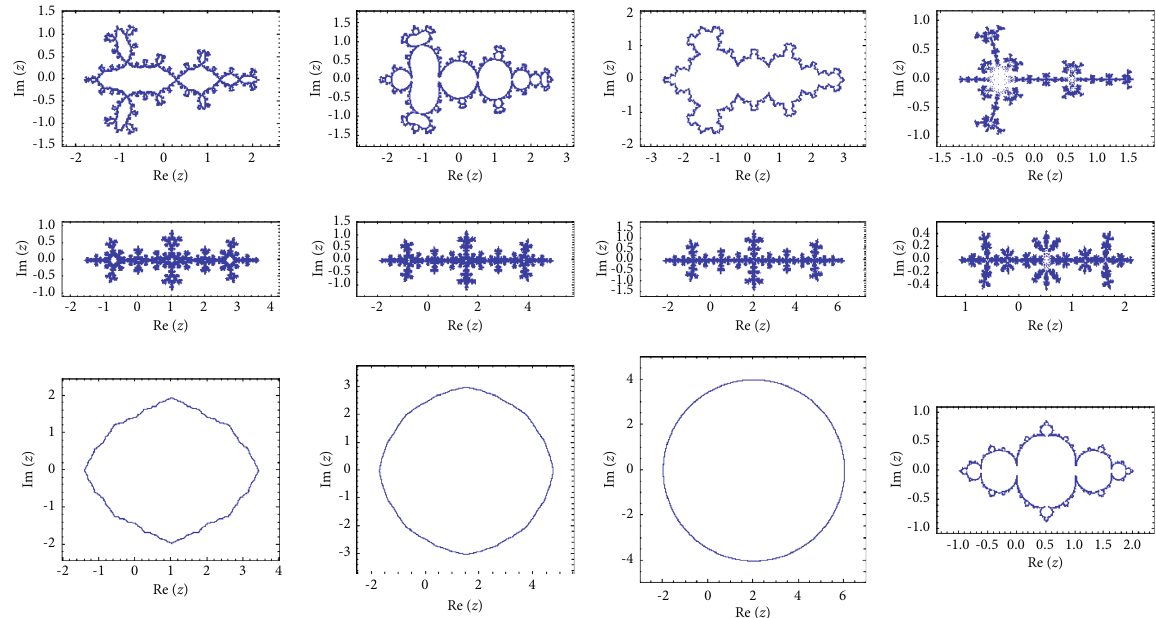
Figure 1: Plot of J ( β )